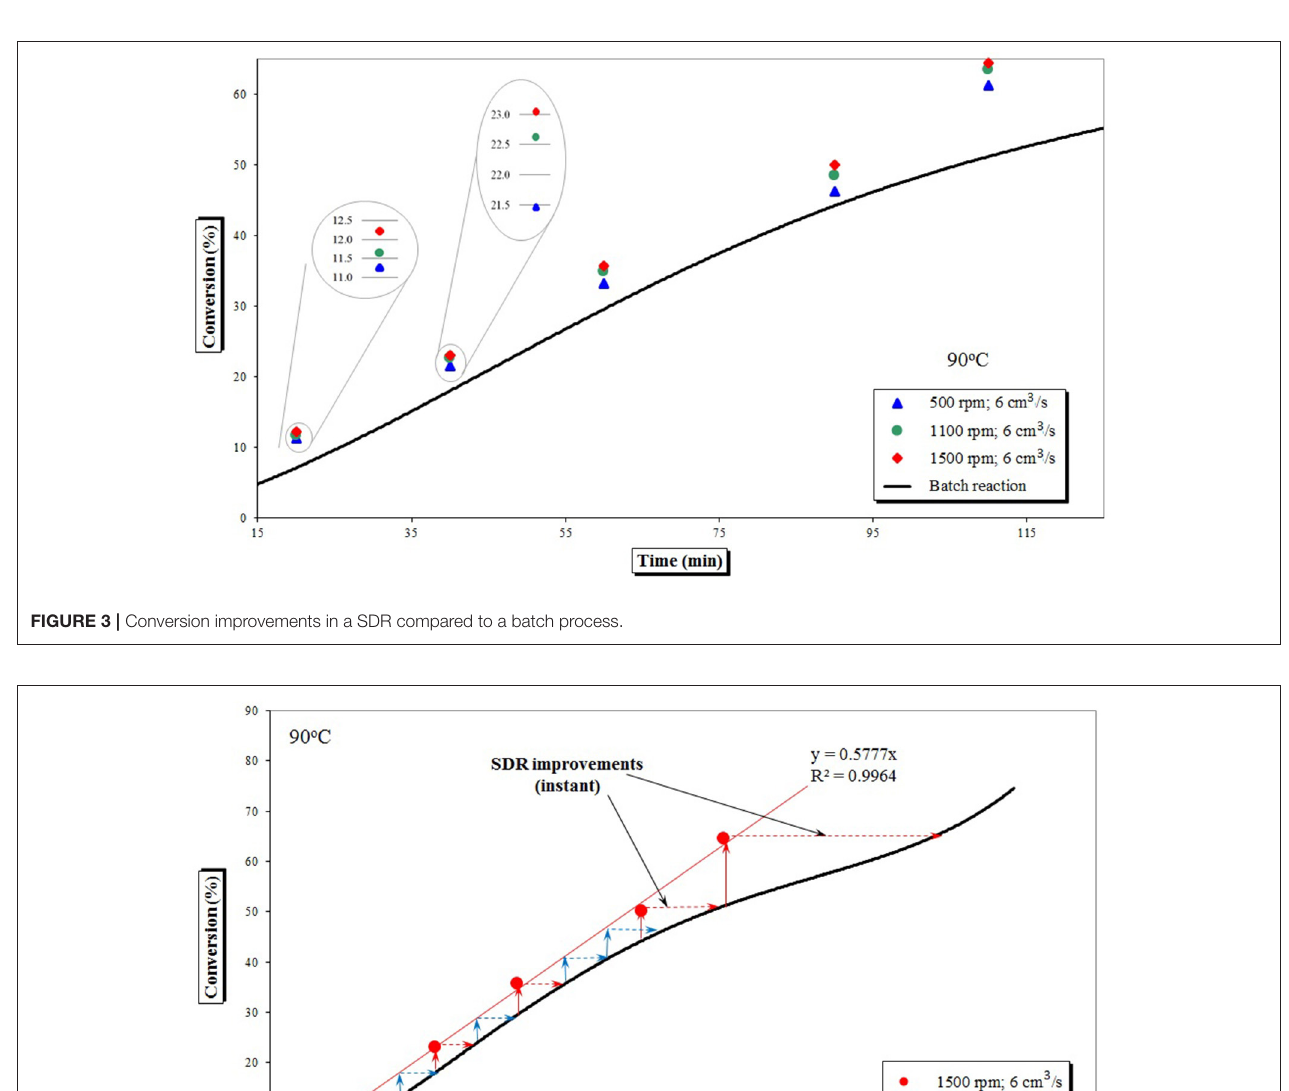
Figure 6 for batch reaction samples taken every 10